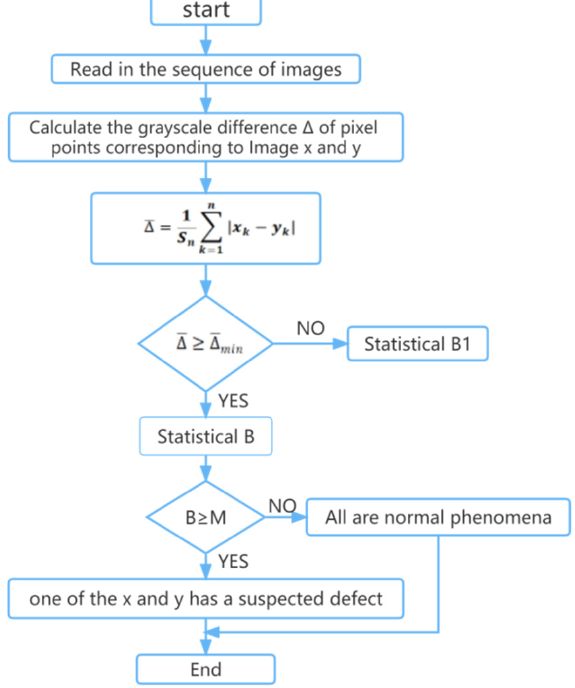
Figure 3. PE gas pipeline defect screening algorithm.